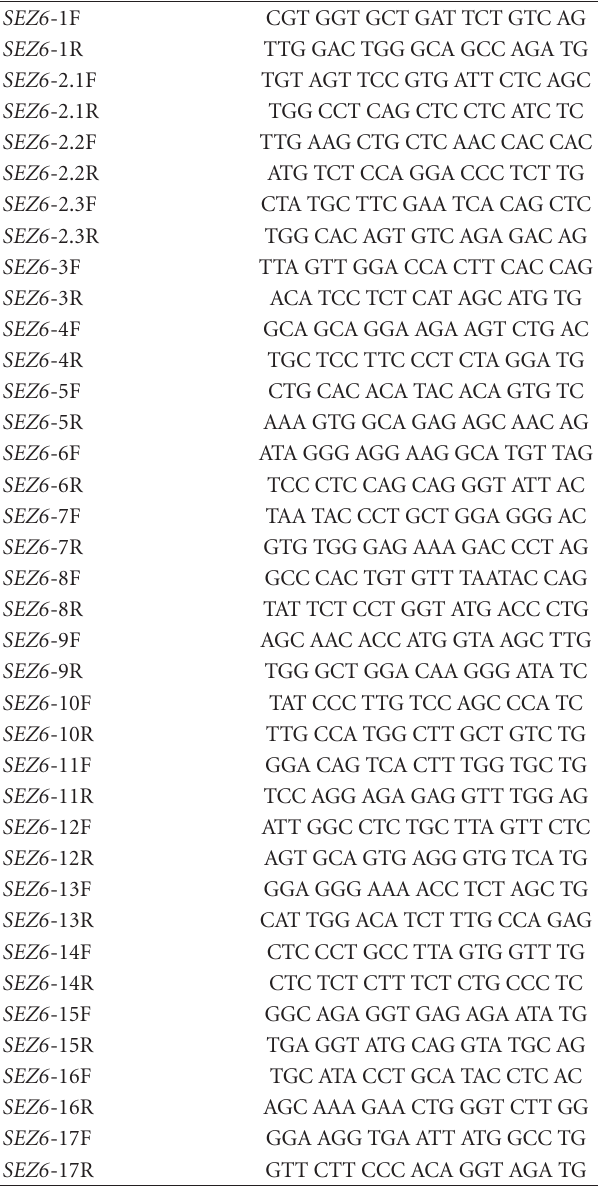
Table 1: Primers used to amplify SEZ6 exons for mutation screen-